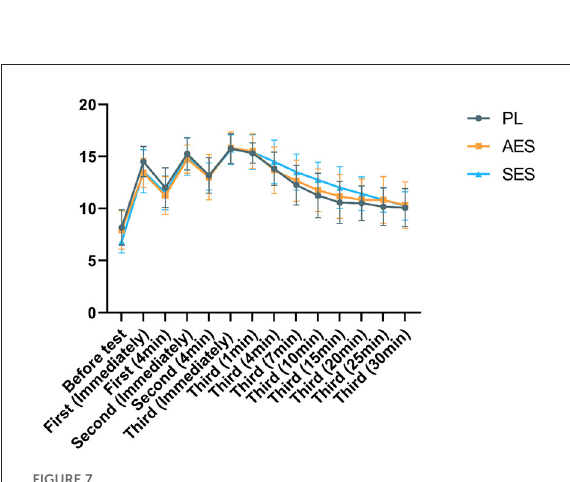
FIGURE7 Ratings of perceived exertion (RPE) in three groups at each moment. Values are means ± SD. First (N min): N minute following the first WAT; Second (N min): N minute following the second WAT; Third (N min): N minute following the third